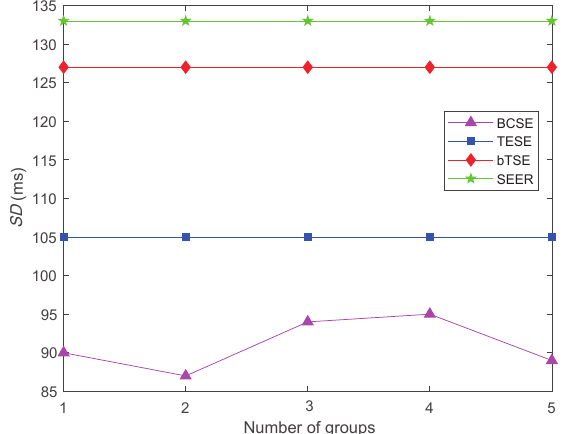
Fig. 8 Comparison of the average SD of the BCSE model and other